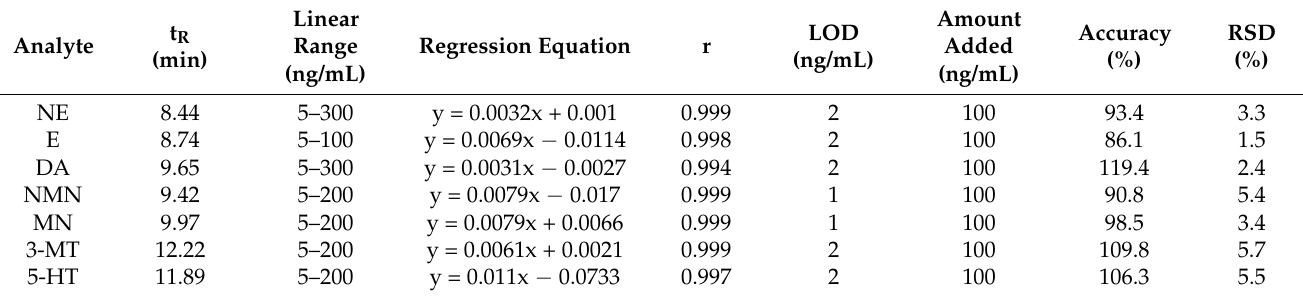
Table 2. Analytical performance of the developed on-line PFSPE–HPLC method for detection of biogenic monoamines and their metabolites in plasma.